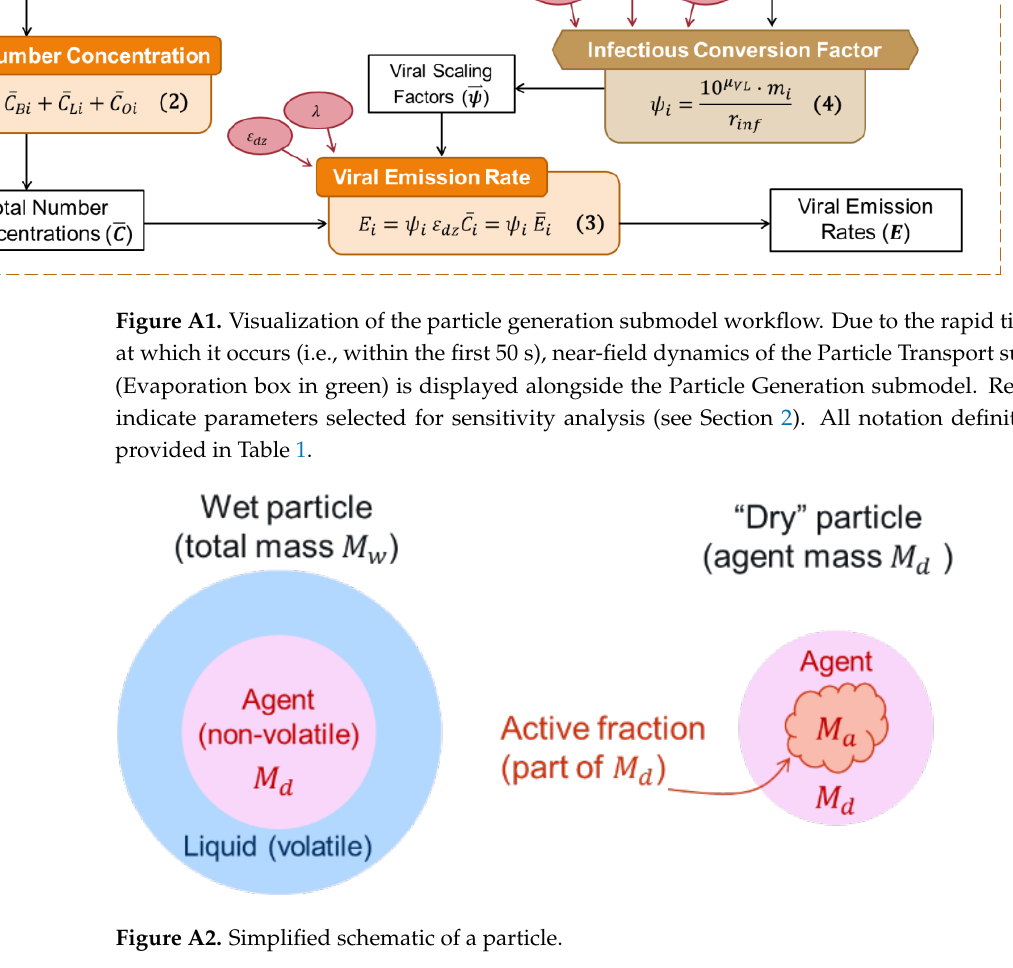
Table A1. Components of a saliva particle. The first two columns were calculated in [48] and the other columns were calculated. Component